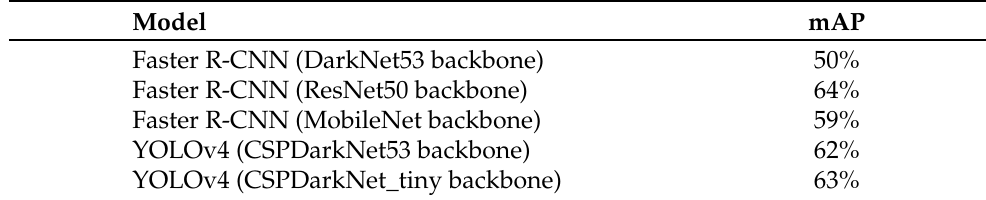
Table 5. Quantitative testing results for the different variants of computer vision object detection models implemented for plastic-bag contamination detection.